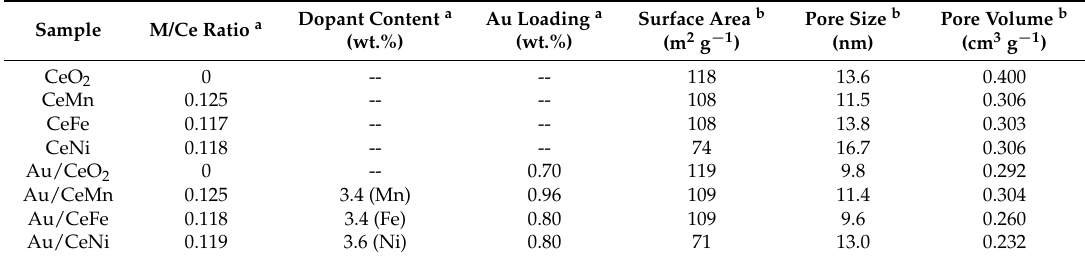
Table 1. Chemical composition and textural properties of CeO 2 , CeM mixed oxides with different dopants and corresponding supported Au/CeM catalysts (M = Mn, Fe and